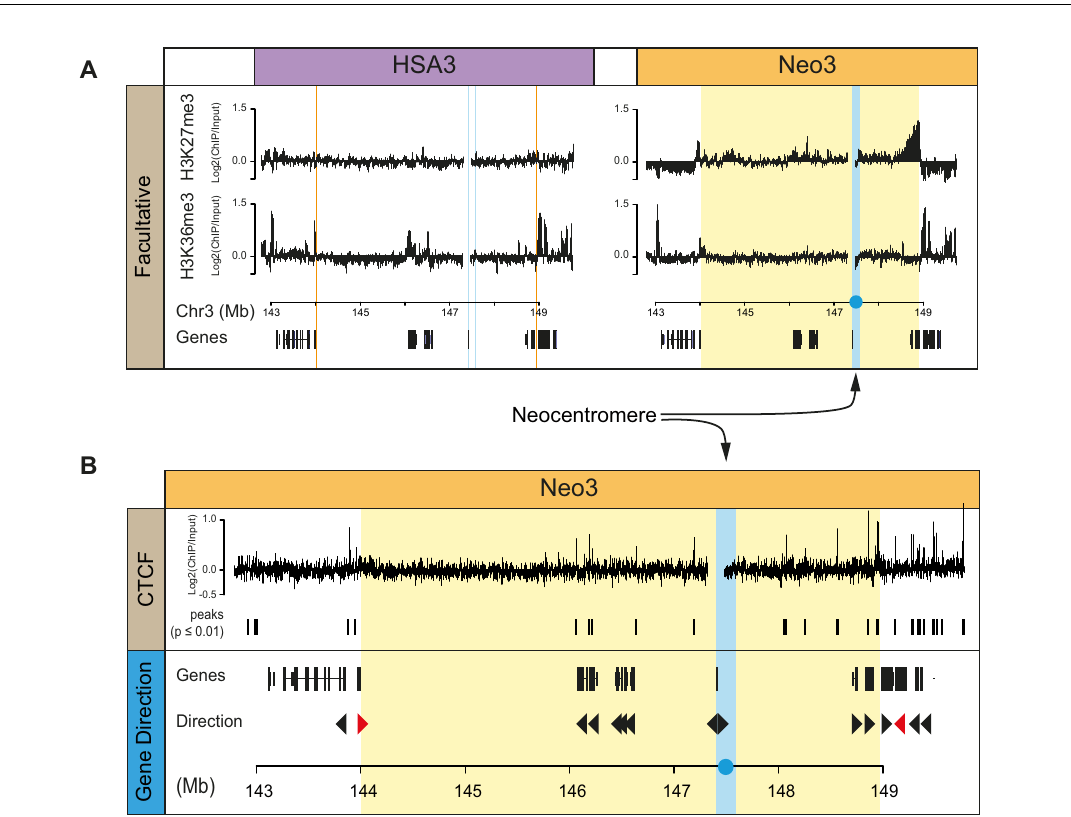
Fig. 2 | RNA pol II binding at a functioning human centromere. A Normalised transcription across HSA3 and Neo3 analysed by RNA-seq. B Distribution of RNA pol II binding at 3q24 for Neo3 (orange) and HSA3 (purple) chromosomes. Top, RNA pol II CTD antibody (D2, Diagenode), bottom, RNA pol II CTD antibody from Hiroshi Kimura (HK1). Horizontal line (arrows) corresponds to a random permu- tation analysis with p =0.01. Signi fi cant peaks ( p <0.001) called using the Ringo package for Neo3 (orange) and HSA3 (purple) are shown below the tracks. C Representative image of RNA polII (CTD domain, Diagenode) (green)and CENP-